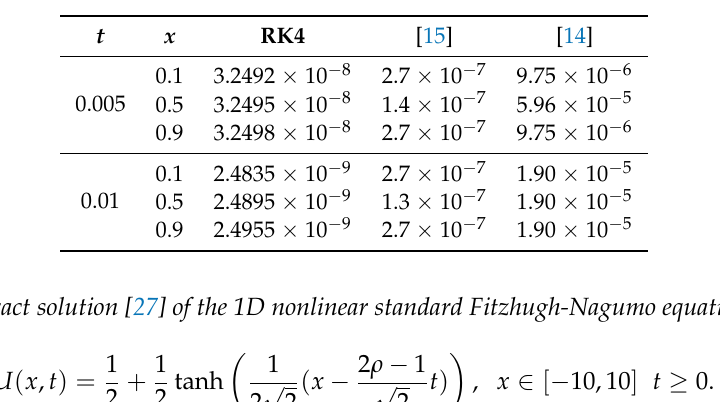
Table 7. Comparisons between the results obtained by the LMM with those adapted from [14,15] in term of L abs error norm for Test Problem 5.